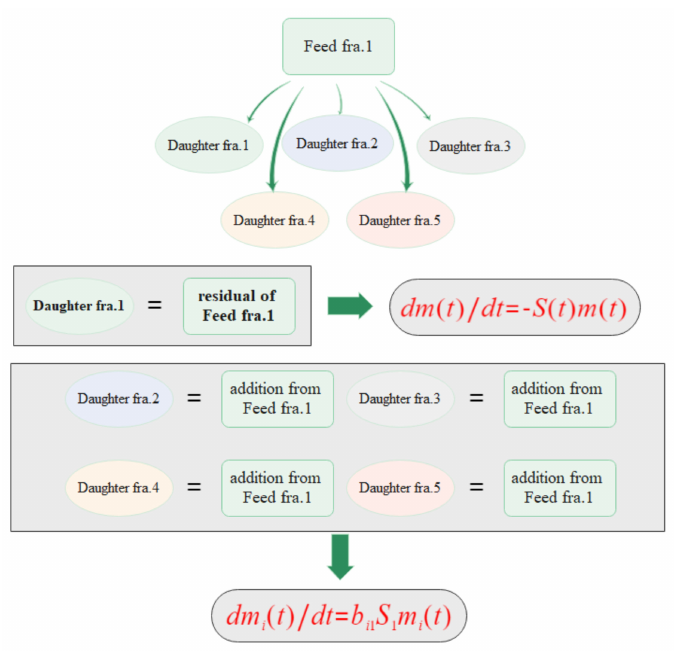
Figure 2. The logic diagram of the population balance model for narrow-size